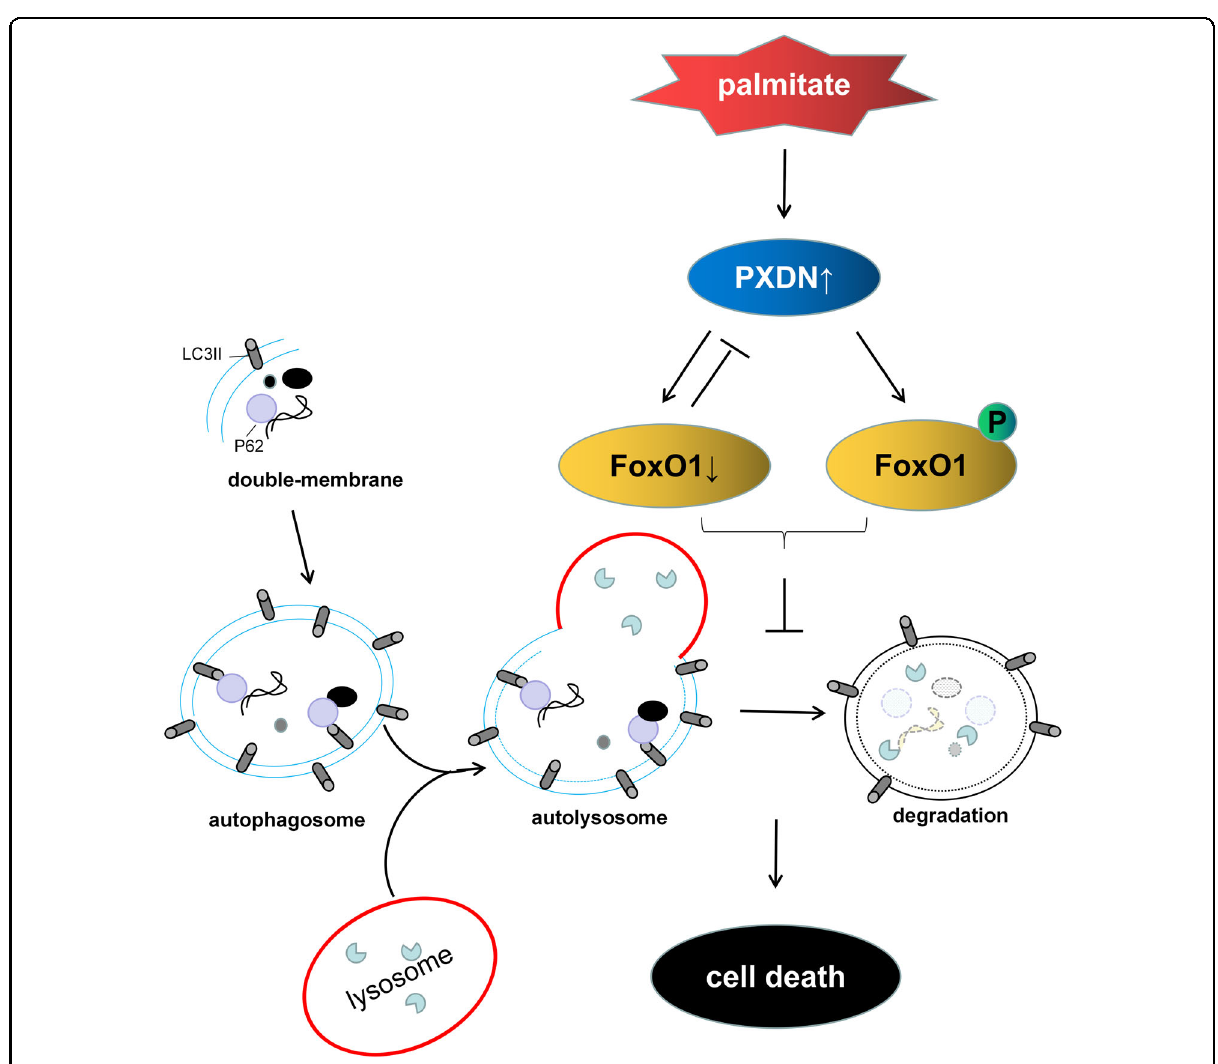
Fig. 6 Schematic depiction of the mechanism of PXDN-induced cell death in insulin-resistant cardiomyocytes. The increased protein level of PXDN stimulated by PA impaired autophagic fl ux to induce cell death in insulin-resistant cardiomyocytes via down-regulating the expression of FoxO1 and promoting FoxO1